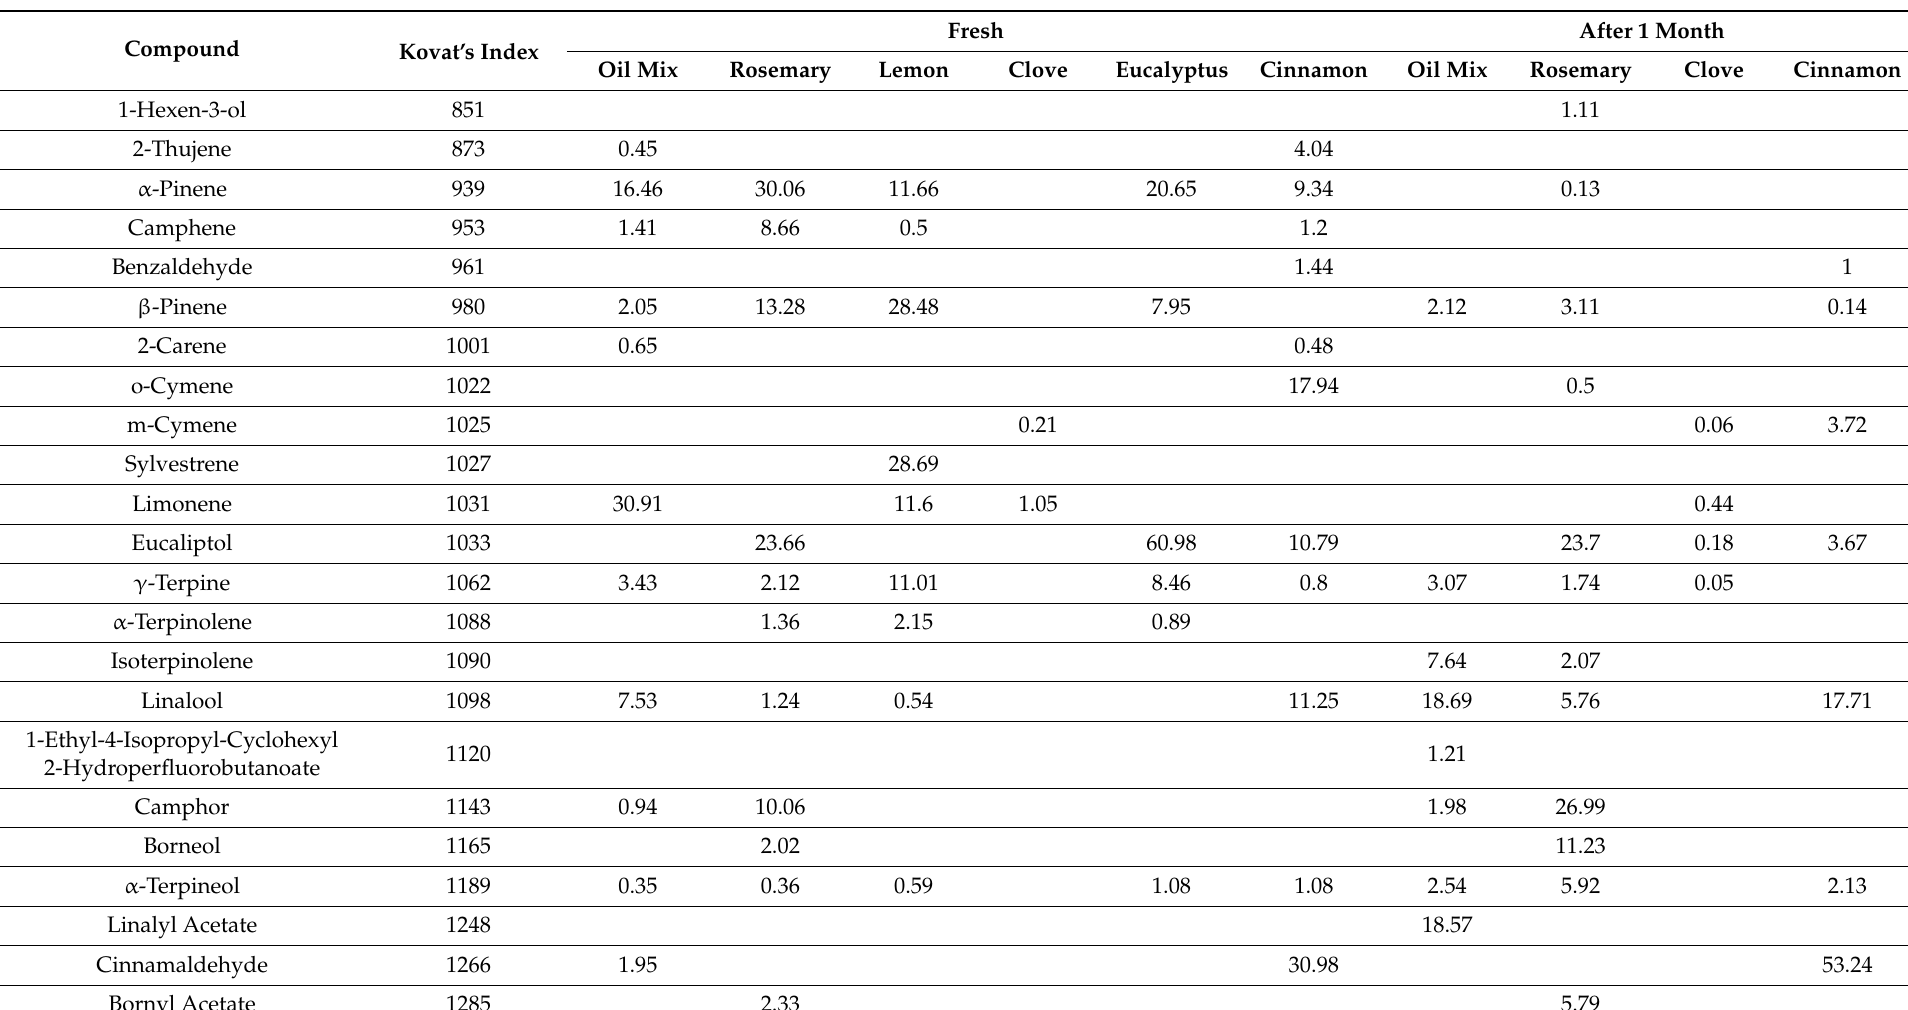
Table 1. Percentage of volatile compounds in fresh and storage oil mix, with rosemary, lemon, clove, eucalyptus, and cinnamon essential oils. Fresh After 1 Month Compound Kovat’s Index Oil Mix Rosemary Lemon Clove Eucalyptus Cinnamon Oil Mix Rosemary Clove